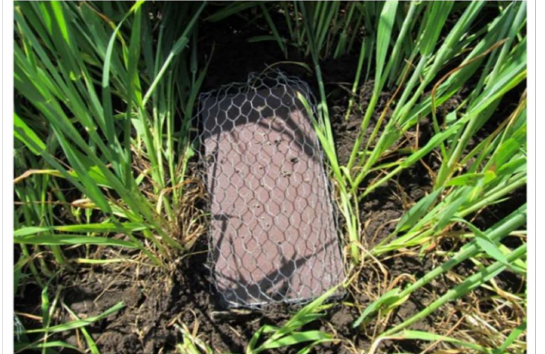
Figure 2. Seed cards (covered by wire mesh, hole size—25 mm) placed horizontally inside wheat fields between crop stands (Photo: Osman Mohammed, Hungary, Sz á r í t ó puszta, Gödöll˝o,